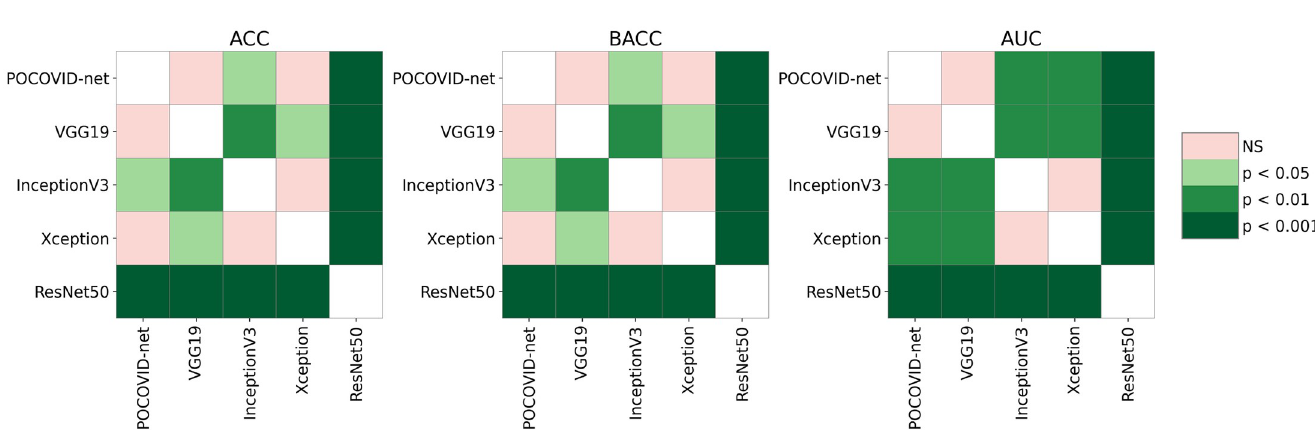
PLOS ONE | https://doi.org/10.1371/journal.pone.0255886 August 13, 2021 14 /